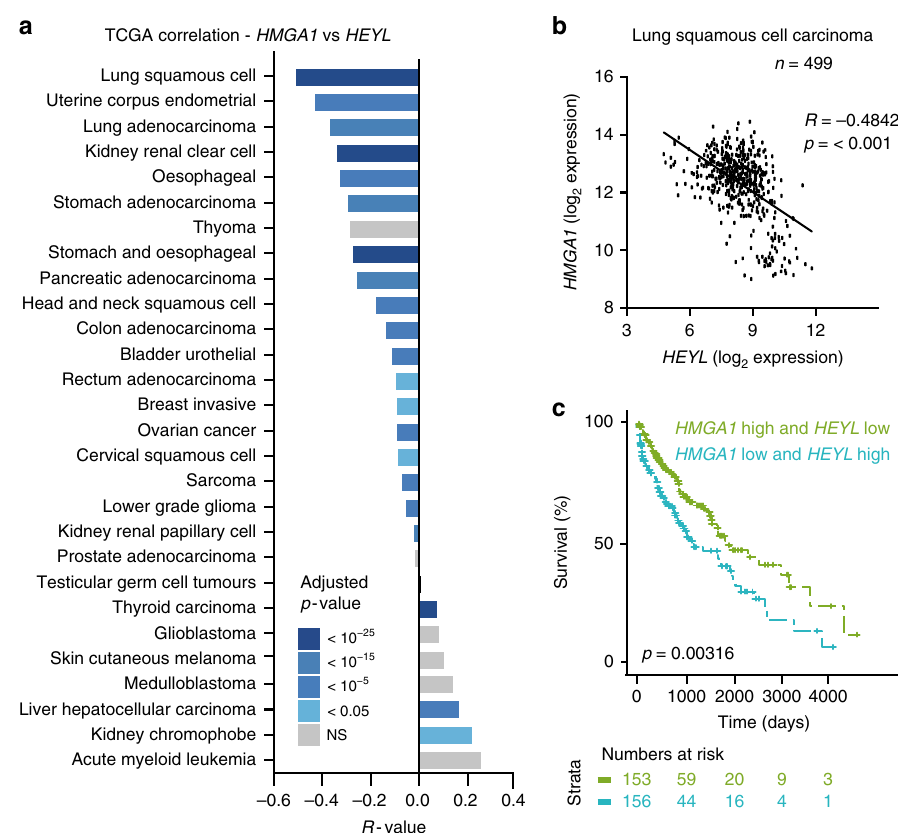
Fig. 7 HEYL and HMGA1 gene expression values anti-correlate in multiple human tumour types. a Pan-cancer analysis of the TCGA database. Correlation between HMGA1 and HEYL is plotted in the indicated tumour types. Colours represent Bonferroni adjusted p -values on Pearson ’ s correlation p -values. NS = not signi fi cant. b Log HMGA1 against HEYL in lung squamous cell carcinoma (LSCC). c Kaplan – Meier plot showing survival of LSCC 2 expression of patients strati fi ed by HMGA1 and HEYL gene